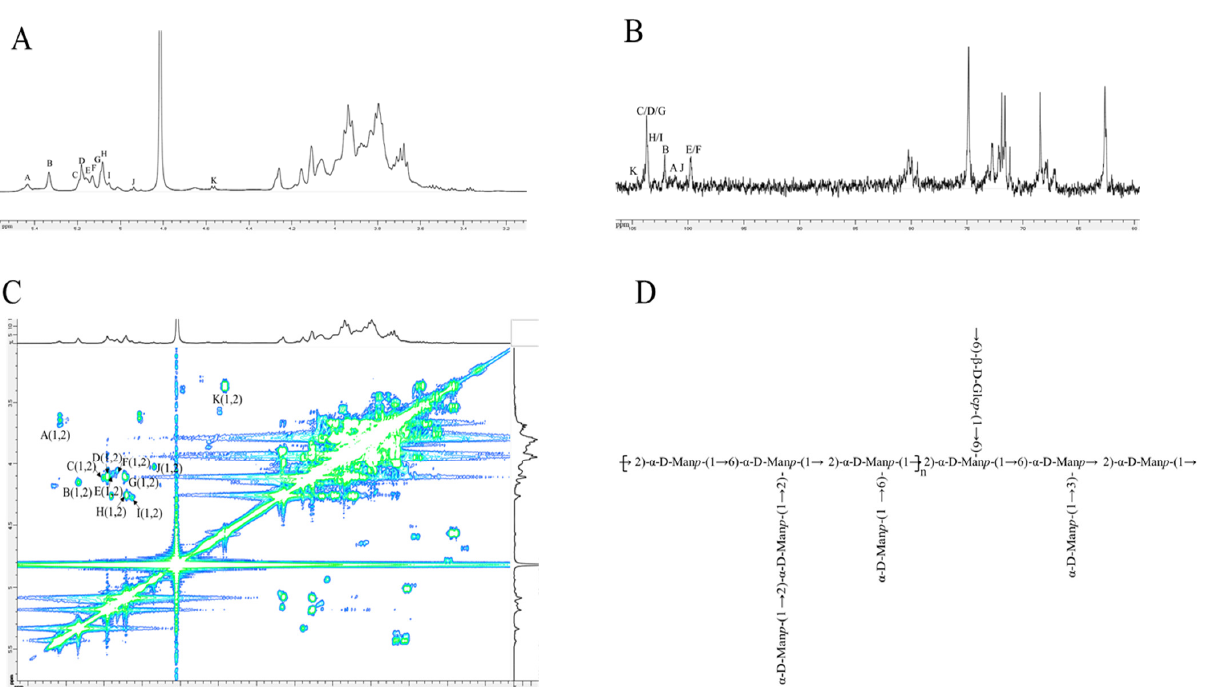
Figure 3. NMR spectra of LPB8-1 recorded in D 2 O at 298 K: ( A ) 1D-1H spectrum; ( B ) 1D-13C spectrum; ( C ) COSY spectrum; ( D ) one putative structure of LPB8-1. Based on the eleven sugar signals, a representative signal of residue B was exten- sively investigated. Residue B had a relatively intensive anomeric proton signal at δ 5.33